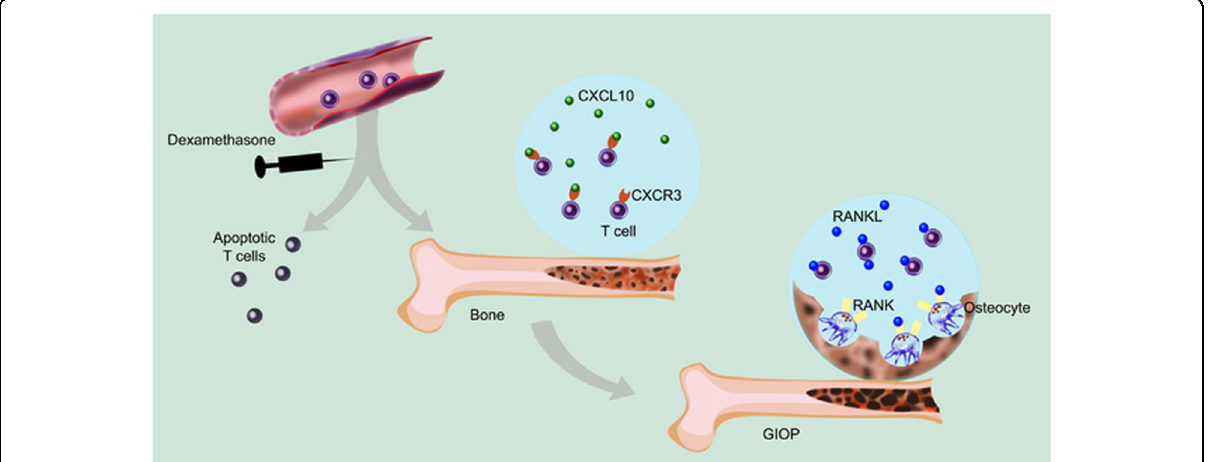
Fig. 1 Proposed involvement of T cells in glucocorticoid-induced osteoporosis. While peripheral T cells may undergo apoptosis upon exposure to dexamethasone, some T cells accumulate in the bone marrow in a CXCL10-CXCR3 axis-dependent manner. Latter T cells are protected from cell death and promote RANKL-induced osteoclastogenesis. Illustration by Aldona von Gunten. GIOP glucocorticoid-induced osteoporosis, RANK receptor activator of NF- κ B, RANKL RANK